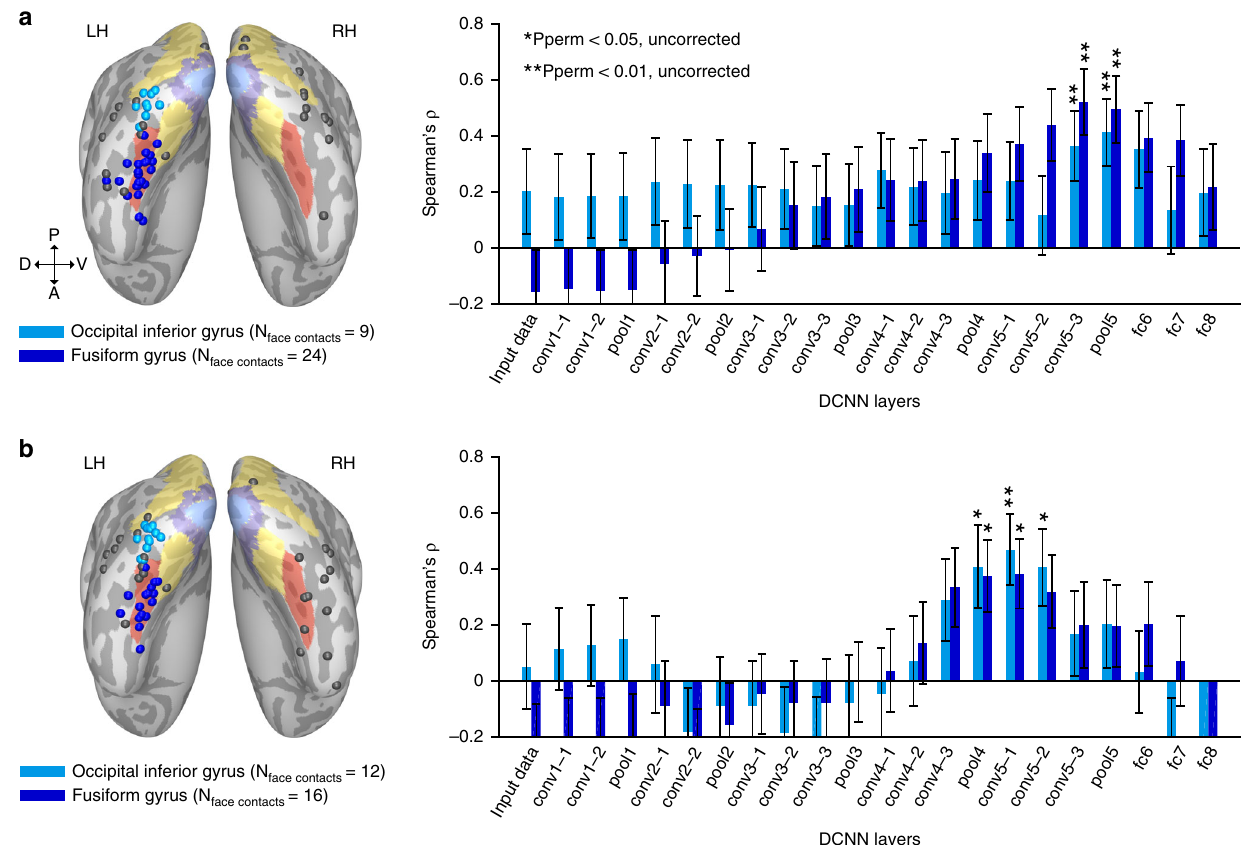
Fig. 5 Match between neural and DCNN face-spaces in the occipital and temporal clusters of face contacts. a The same analysis as presented in Fig. 2a for set 1, with the difference of computing the correlation coef fi cients separately, for an occipital cluster (occipital inferior gyrus) and for a temporal cluster (fusiform gyrus) of face contacts. Anatomical locations of contacts assigned to the two clusters are presented on the in fl ated common cortical surface (surface colored labels are identical to those in Fig. 1a). Gray contacts were not assigned to any cluster. Error bars denote bootstrap s.e.m. on image pairs. b Same as panel a for the face contacts and images included in set 2. Anatomical labels were taken from individual patients ’ cortical surface reconstruction; therefore, the contacts do not always fall within the targeted gyri on the common surface. Note that the correlation pro fi le remained highly similar for the two clusters, with no signi fi cant difference found in any of the layers (permutation test on contacts ’ ROI